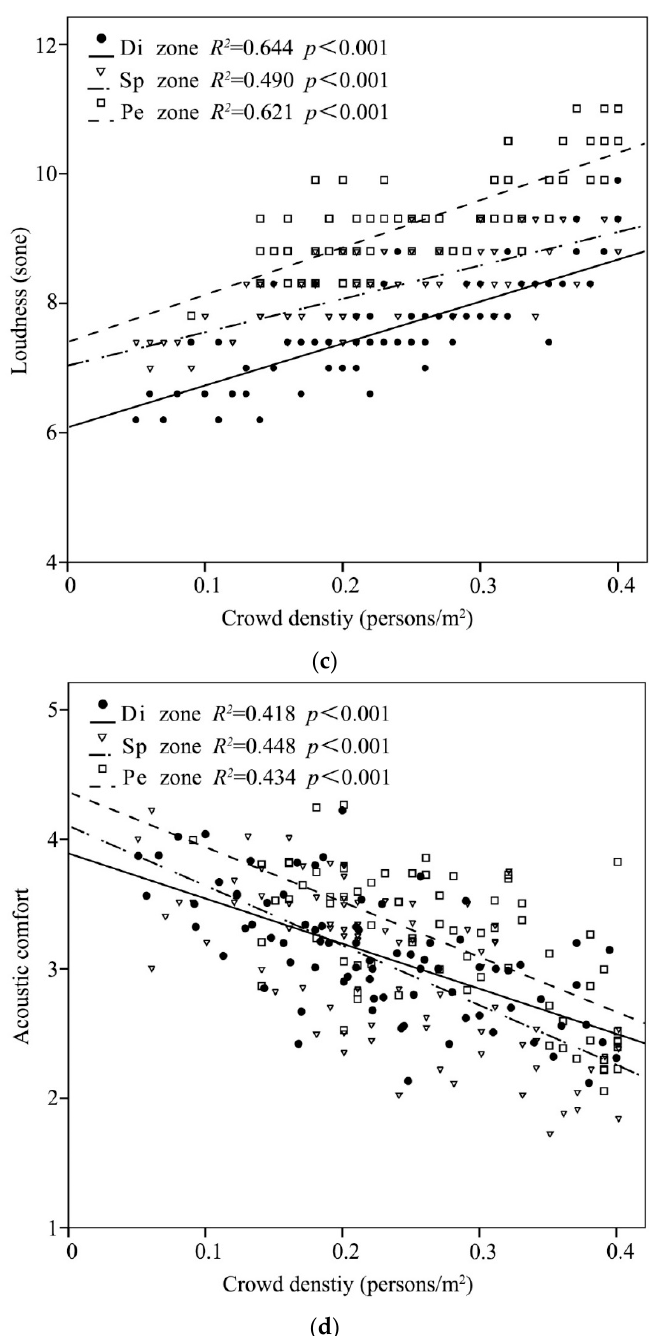
Figure 9. The influence of commercial function: ( a ) the relationship between crowd density and the number of talkers; ( b ) the relationship between crowd density and sound pressure level; ( c ) the relationship between crowd density and loudness; ( d ) the relationship between crowd density and acoustic comfort.